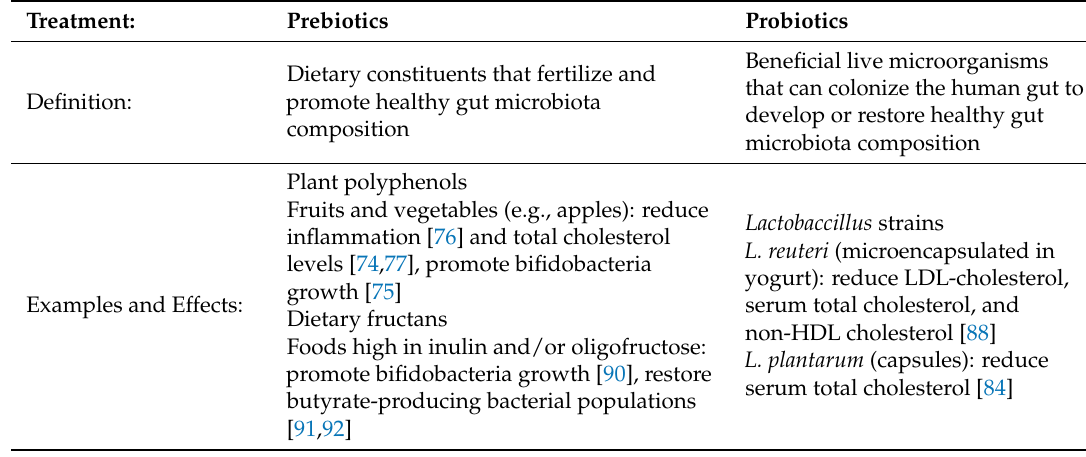
Table 1. Summary of the effects of potential cardiovascular disease (CVD) treatments targeting gut microbiota composition, based on recent